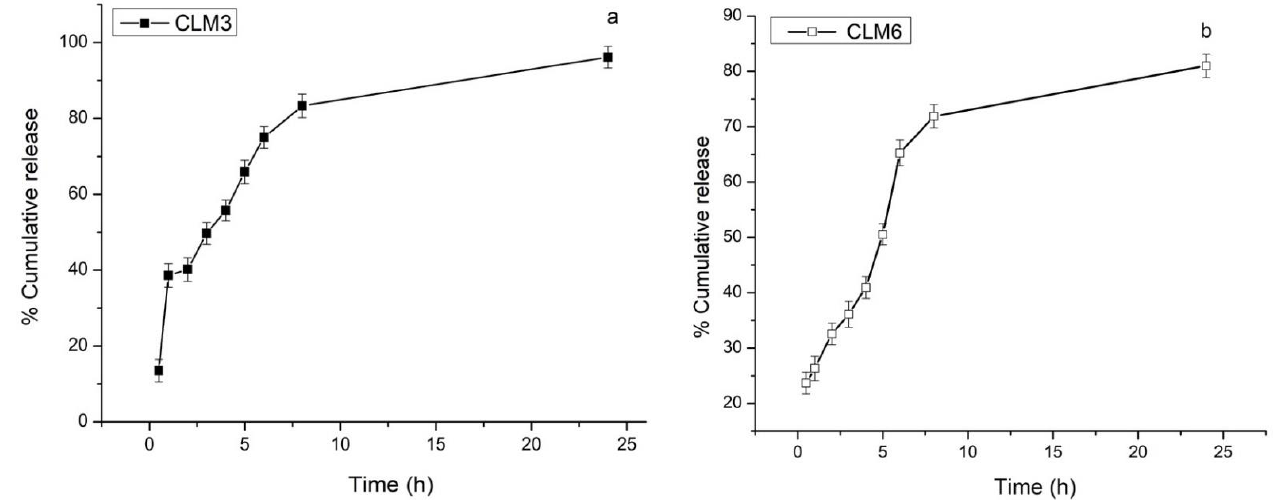
Figure 10. % Cumulative release of clarithromycin from ( a ) CLM3 and ( b ) CLM6. Table 4. In vitro clarithromycin release kinetics from optimized microbeads.